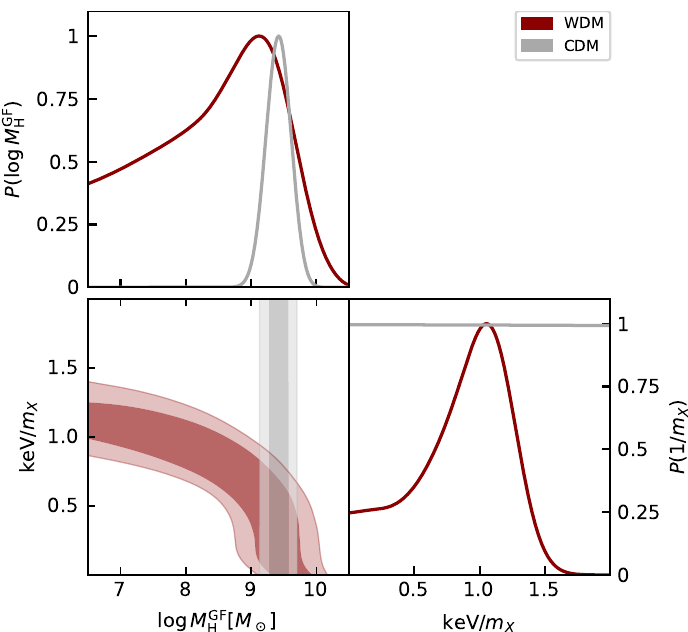
Figure 4. MCMC posterior distributions in the WDM scenario (red contours/lines), for the threshold halo mass for galaxy formation M GF , and the inverse of the DM particle’s mass keV/ m X . For reference, H the outcomes in the standard CDM scenario are also reported (grey contours/lines). The contours show 68% and 95% confidence intervals, and the marginalized distributions are in arbitrary units (normalized to 1 at their maximum value).